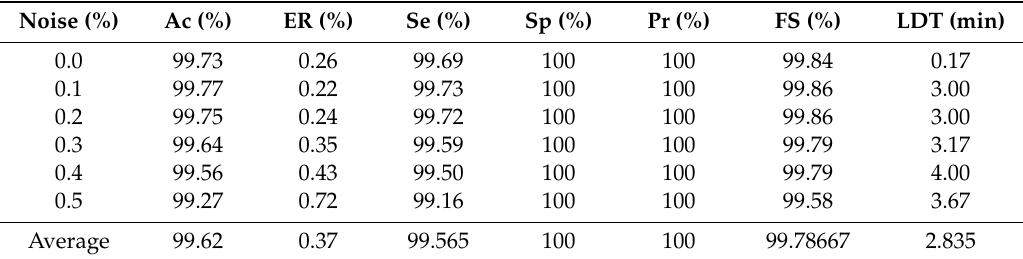
Table 7. Leak detection system performance measures with increasing noise. Leak size was 5% of the nominal flow; 1201 parameters are used for the mass flow rate estimation.